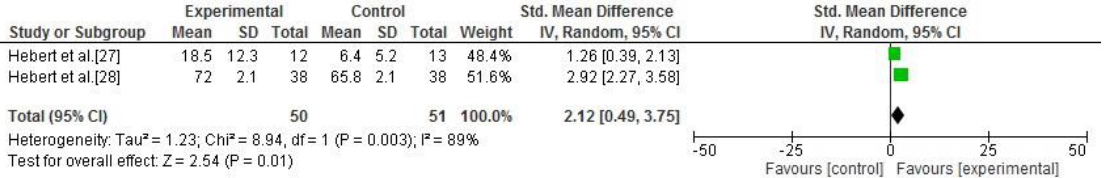
Figure 3. Forest plot of the meta-analysis of postural control (vestibular rehabilitation versus no intervention).